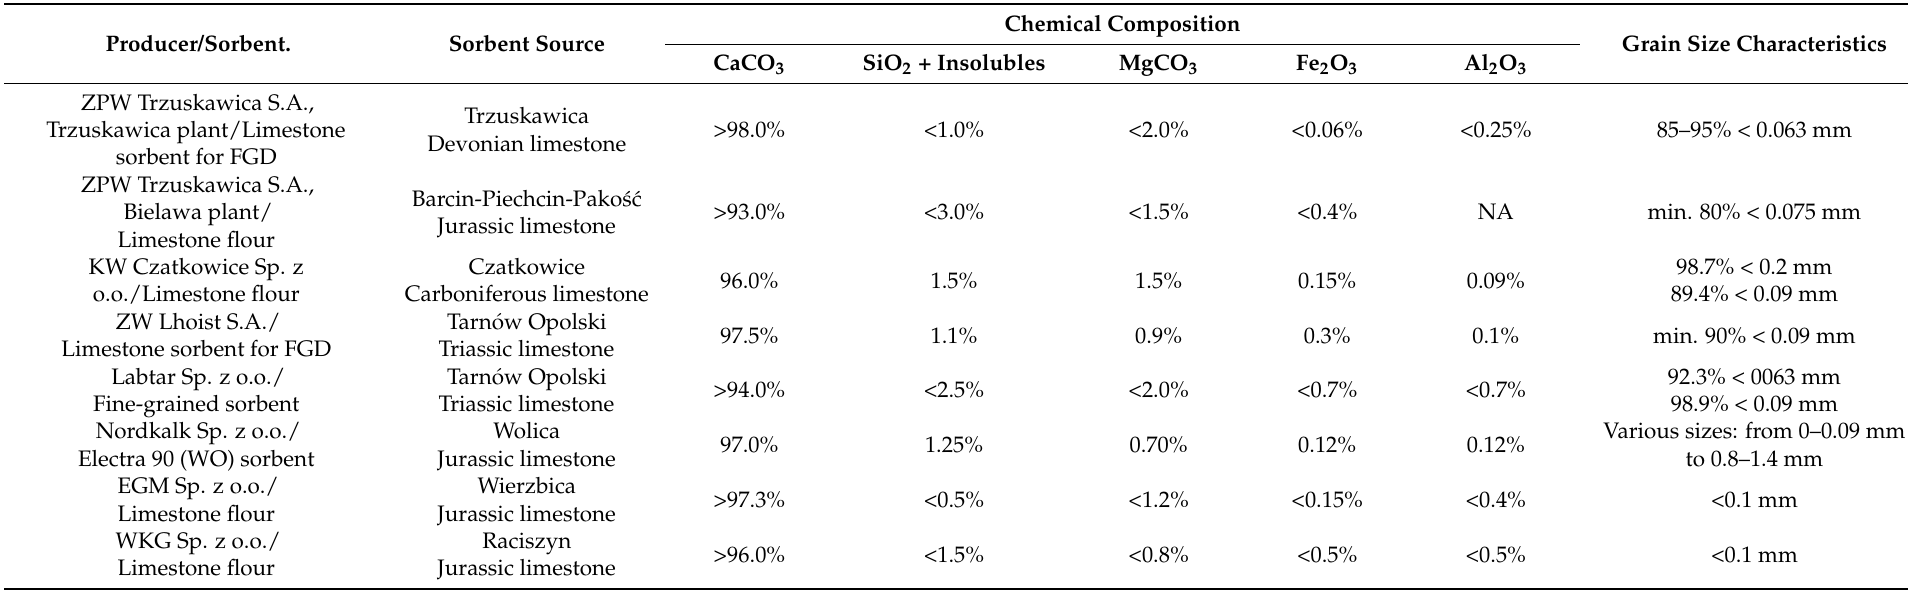
Table 2. Basic quality parameters of major limestone sorbents produced in Poland and utilised in wet limestone FGD process (surveyed producers’ data).